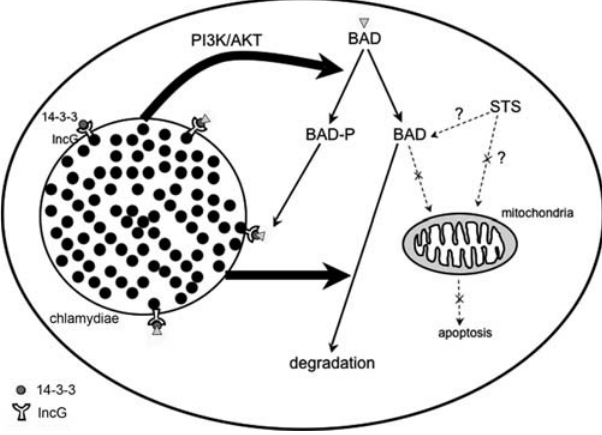
Figure 9. Summary of the Effects of C. trachomatis Infection on BAD Phosphorylation, BAD Degradation, and Host-Cell Death Infection with C. trachomatis leads to activation of PI3K, which in turns results in AKT activation and subsequent BAD phosphorylation. In parallel, infection causes degradation of most unphosphorylated BAD. Simultaneous expression of IncG on the chlamydial inclusion and binding of 14-3-3 b by IncG allows the inclusion to recruit phosphorylated BAD, preventing the ability of the remaining BAD to translocate to the mitochondria and induce host-cell death. DOI: 10.1371/journal.ppat.0020045.g009 PLoS Pathogens |